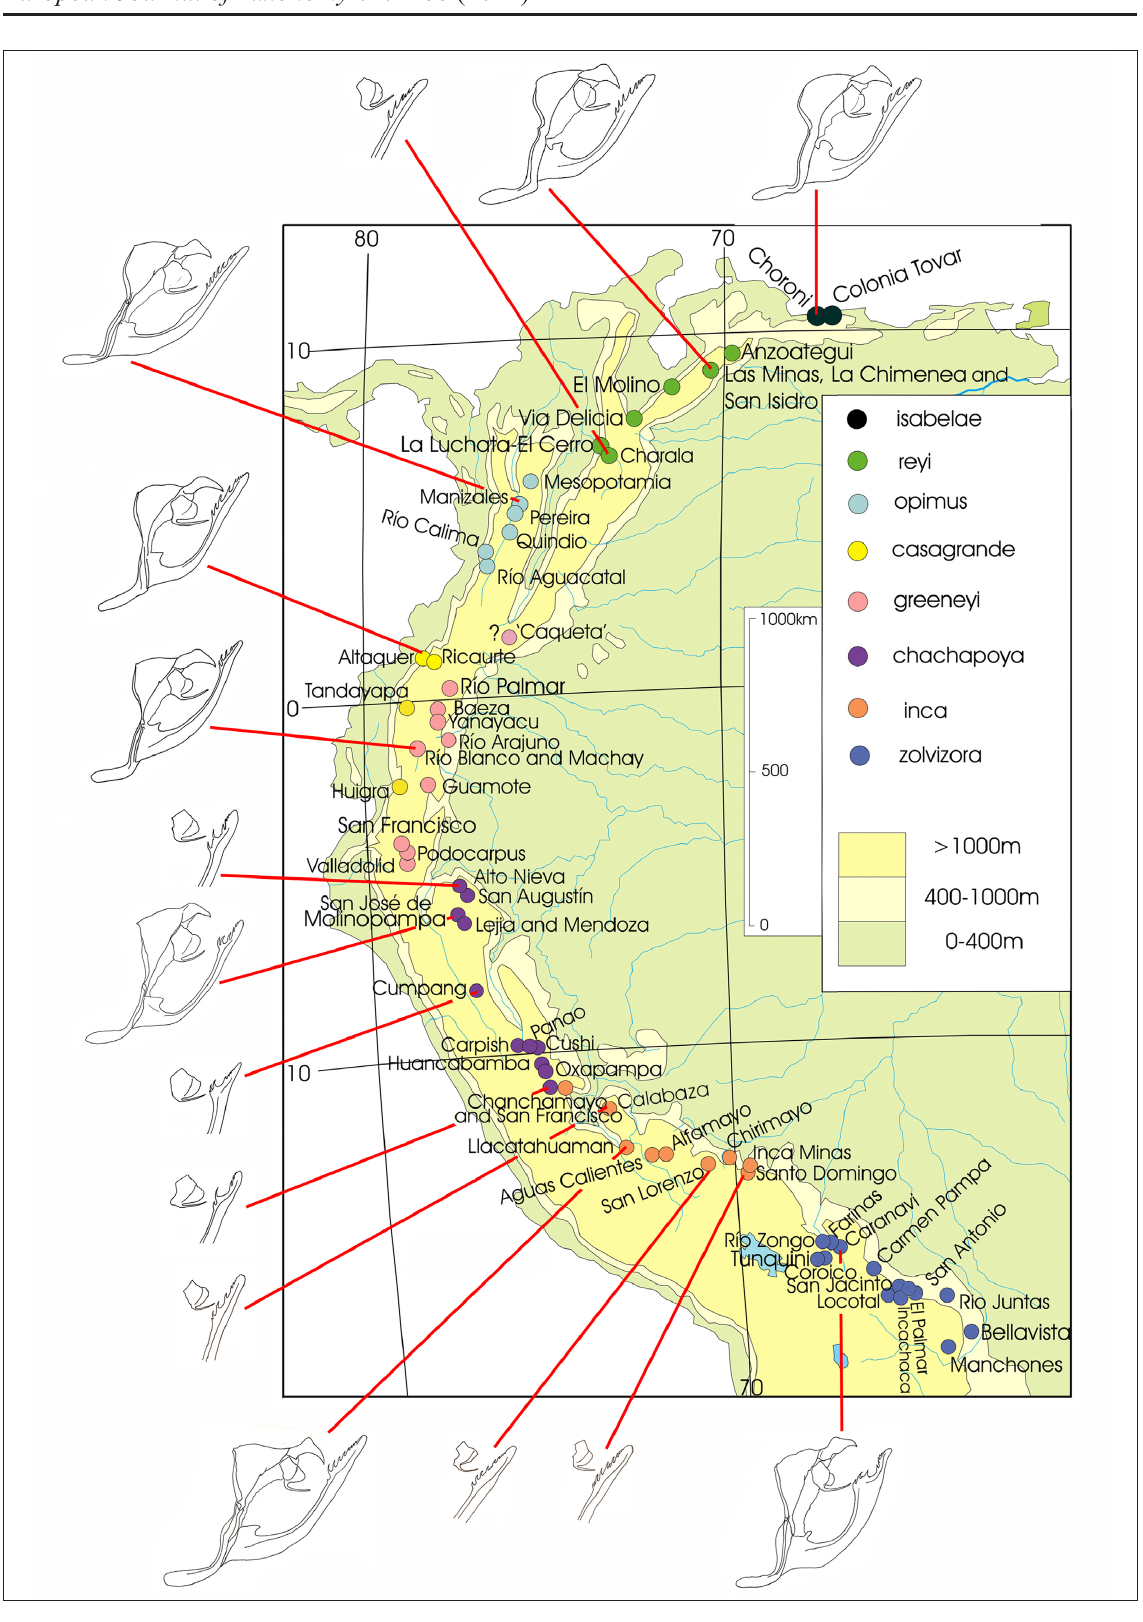
Fig. 16. Geographical distribution of Eryphanis zolvizora subspecies. Unreliable localities are excluded. Male genitalia of specimens illustrating the different subspecies are